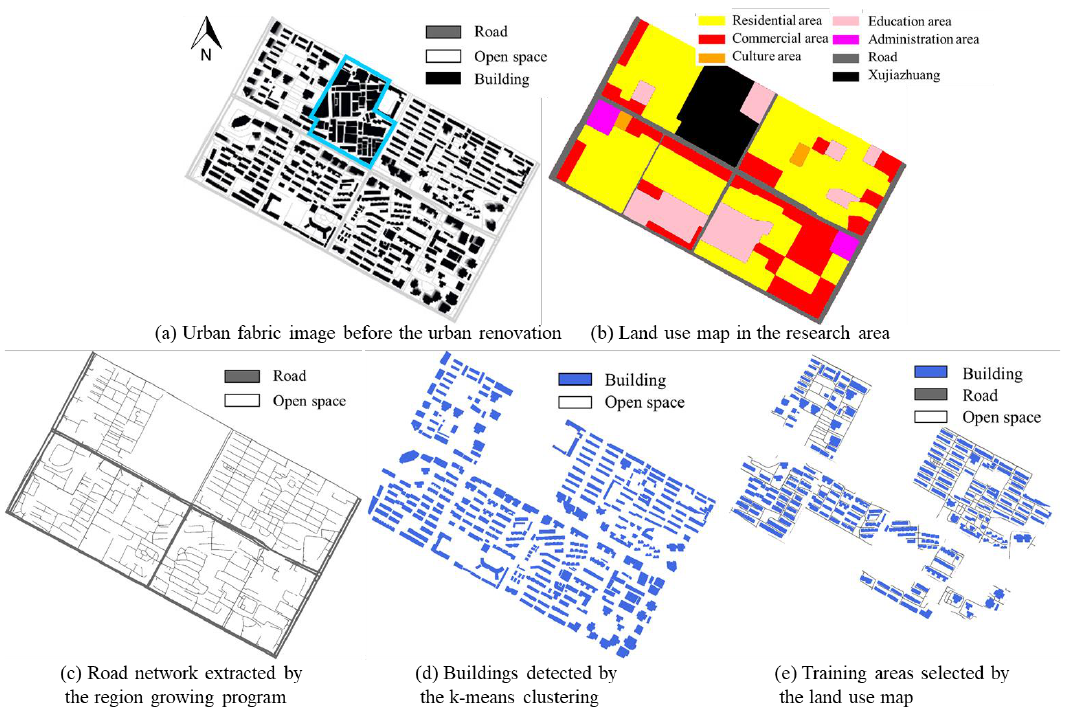
Figure 5. Urban fabric images in the preprocessing step.